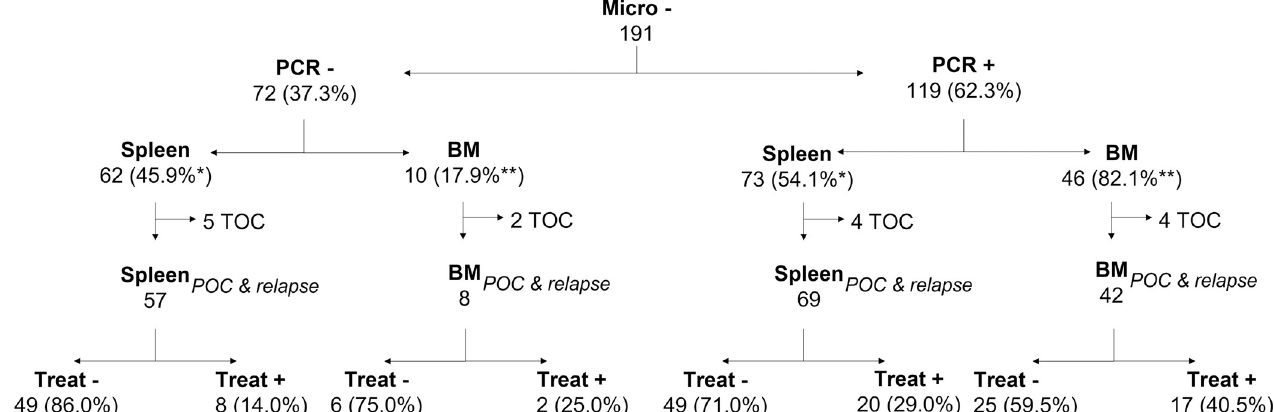
Fig 2. PCR results and treatment provided to patients with a negative bone marrow and splenic aspirate microscopy test. The microscope depicts the microscopy result; the instrument the PCR result, the spleen symbol the microscopy slides containing splenic aspirates; the bone symbol the microscopy slides containing bone marrow aspirates; the syringe whether or not patients were treated. � denominator is all the microscopically negative splenic aspirates, �� denominator is all microscopically negative bone marrow aspirates. Abbreviations : Micro , microscopy; BM , bone marrow sample; POC , point of care/primary VL patients; TOC , test of cure after antileishmanial treatment; Treat , treatment provided or not .